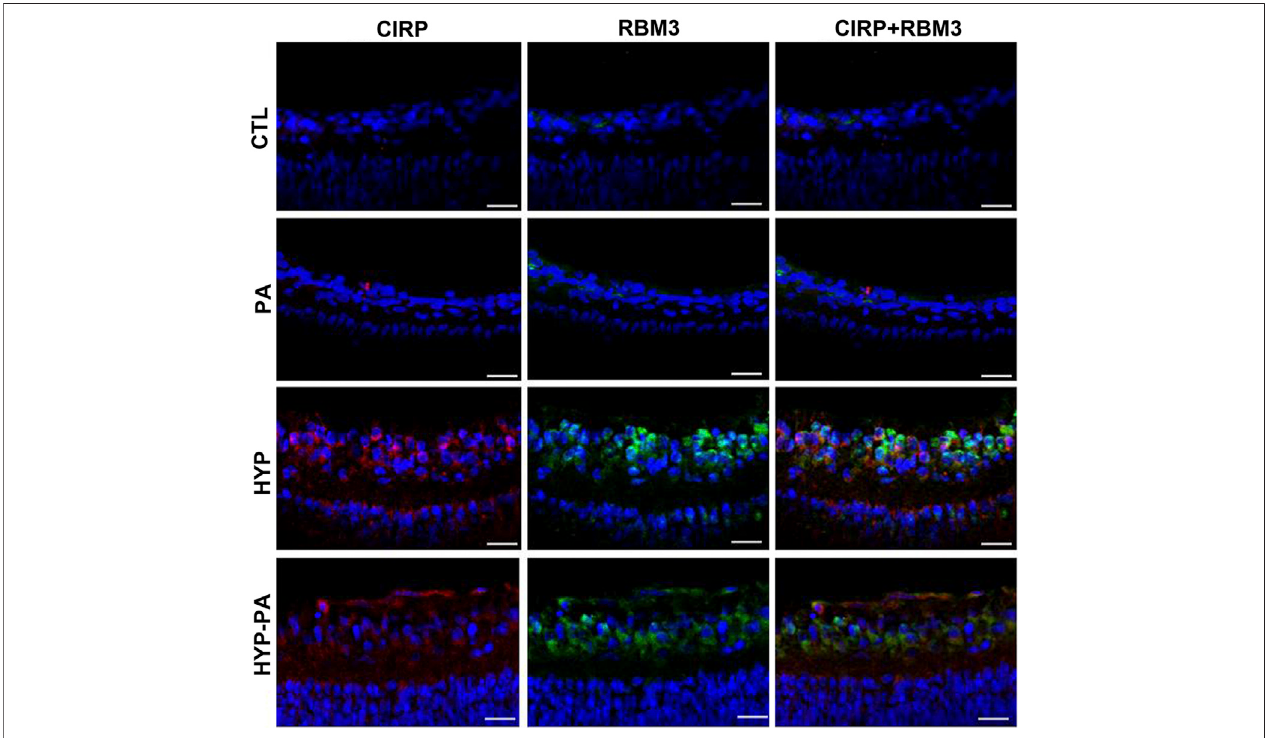
FIGURE 7 | Colocalization of RBM3 and CIRP in cold-treated retinas. The expression of RBM3 (green) and CIRP (red) was very low in the retinas of CTL (upper row) andPA (secondrow) animals.Theexpressionofbothproteinswashighlyinducedfollowingexposuretohypothermiaeitherduring(HYP, thirdrow) orafter(HYP- PA, bottom row) perinatalasphyxia.Abroadcolocalizationpatternwasevidentforbothproteinsinthecytoplasmofganglioncells.Cellnucleiwerecounterstainedwith DAPI (blue). Tissues were collected at 24 h after birth. Scale bars: 10 µm.